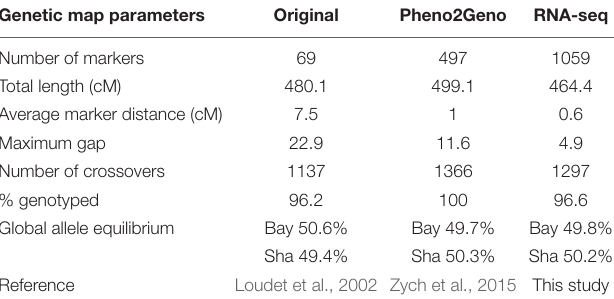
TABLE 2 | Summary of genetic maps for the Bay-0 × Sha RIL population based on145 RILs. Genetic map parameters Original Pheno2Geno RNA-seq